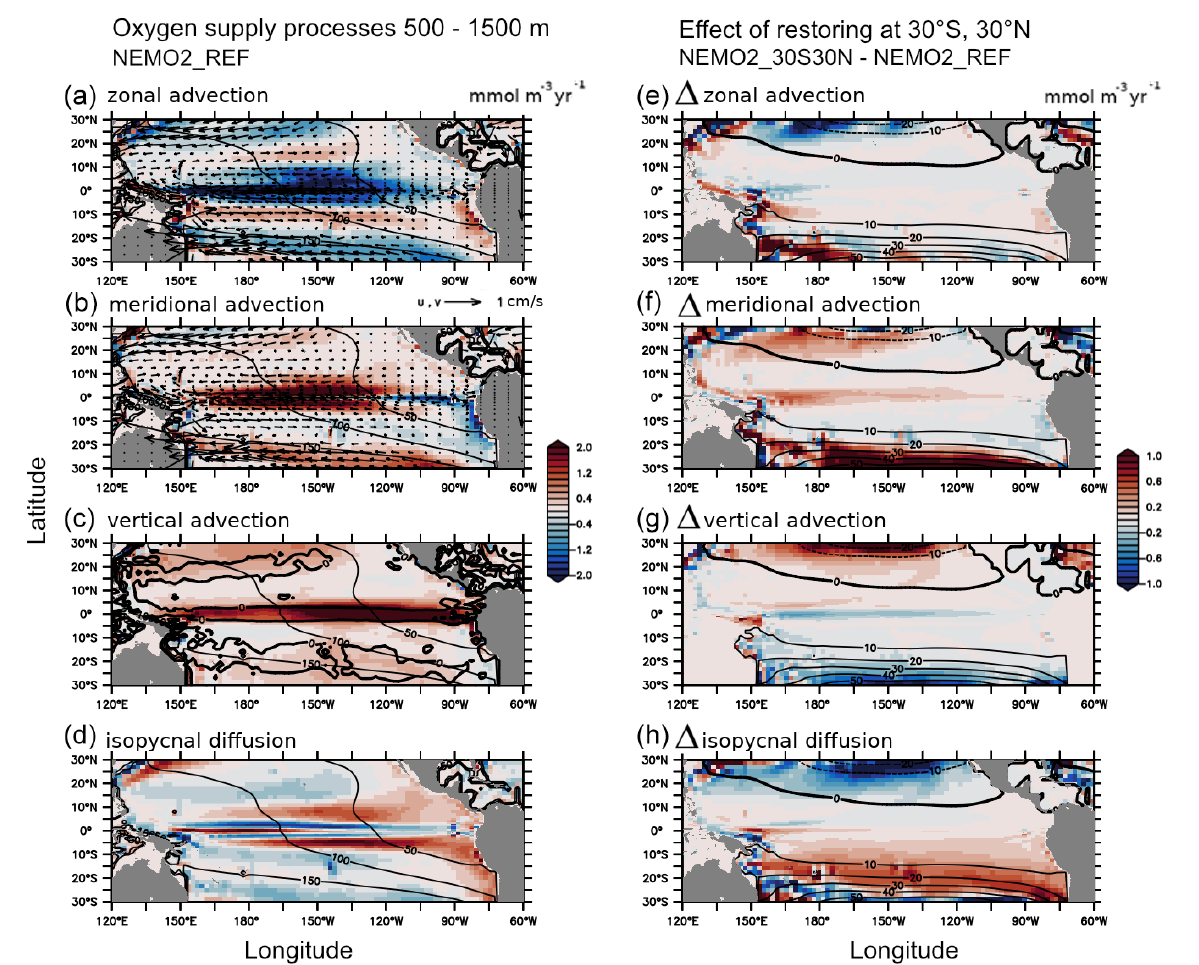
Figure 4. (a–d) Oxygen supply processes (mmolm − 3 yr − 1 ; average 500–1500m) in NEMO2_REF: (a) zonal advection, (b) meridional advection, (c) vertical advection, (d) isopycnal diffusion. The mean meridional and zonal currents are displayed as vectors (meridional, zonal advection). The mean vertical current (0 isoline) is represented as a bold contour (vertical advection). Oxygen levels (mmolm − 3 ) are dis- played as a black contour. (e–h) Difference in oxygen supply processes (mmolm − 3 yr − 1 ; average 500–1500m) between NEMO2_30S30N and NEMO2_REF: (e) zonal advection, (f) meridional advection, (g) vertical advection, (h) isopycnal diffusion. The NEMO2_30S30N– NEMO2_REF oxygen anomaly (mmolm − 3 ) is displayed as a